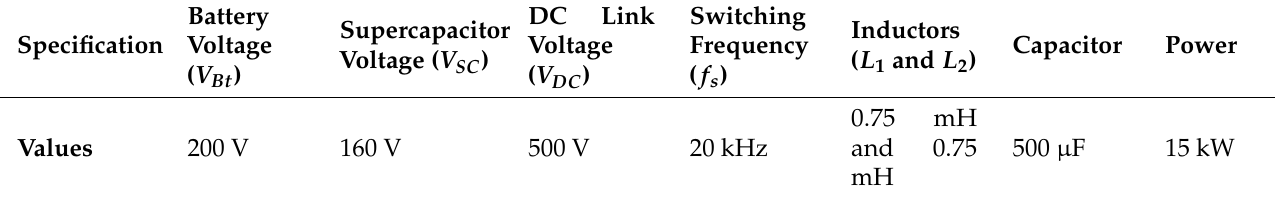
Table 4. Design specifications of the proposed